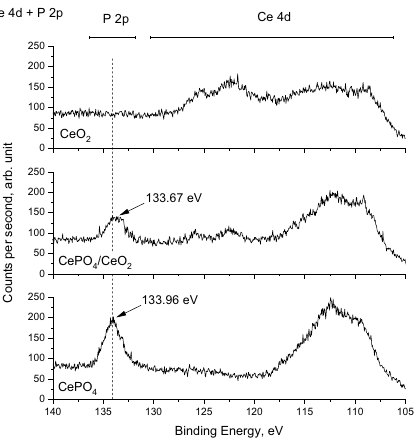
Figure 2. Ce 4d and P 2p high resolution XPS spectra of the catalysts prepared in this work.